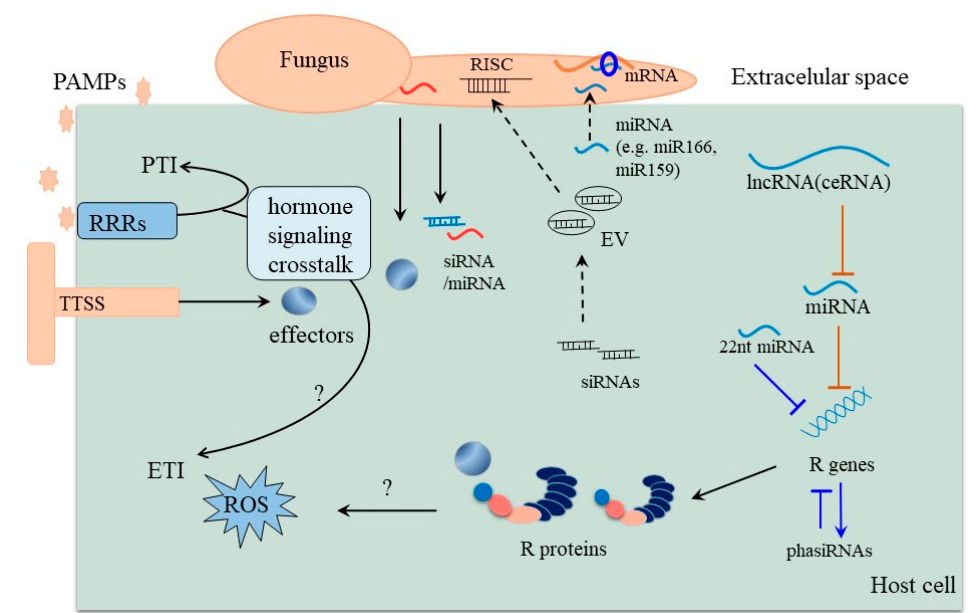
Figure 2. Hosts and pathogens are engaged in an arms race mediated by sRNAs. In plant–pathogen interactions, plants recognize PAMPs (pathogen-associated molecular pattern) with PRRs (pattern recognition receptor) to trigger innate immunity against most pathogen infections. Pathogens, in turn, secrete effectors including effector proteins and some sRNAs to facilitate infection. Some plant NB-LRR proteins are activated by effector proteins, triggering the second layer of immunity response, the so-called ETI. Additionally, hosts simultaneously export siRNAs and miRNAs to induce cross-kingdom gene silencing in the pathogen. Some plant miRNAs targeting disease resistance genes can be decoyed by certain specific lncRNAs, which attenuates the repression of miRNAs on their targets. EV: extracellular vesicles; TTSS: type III secretion system. (Question symbols indicate predicted characteristics that need further Table 1. Summary of disease-related cross-kingdom sRNAs acting in different plants and pathogens. Plant sRNA (Pathogen sRNA)